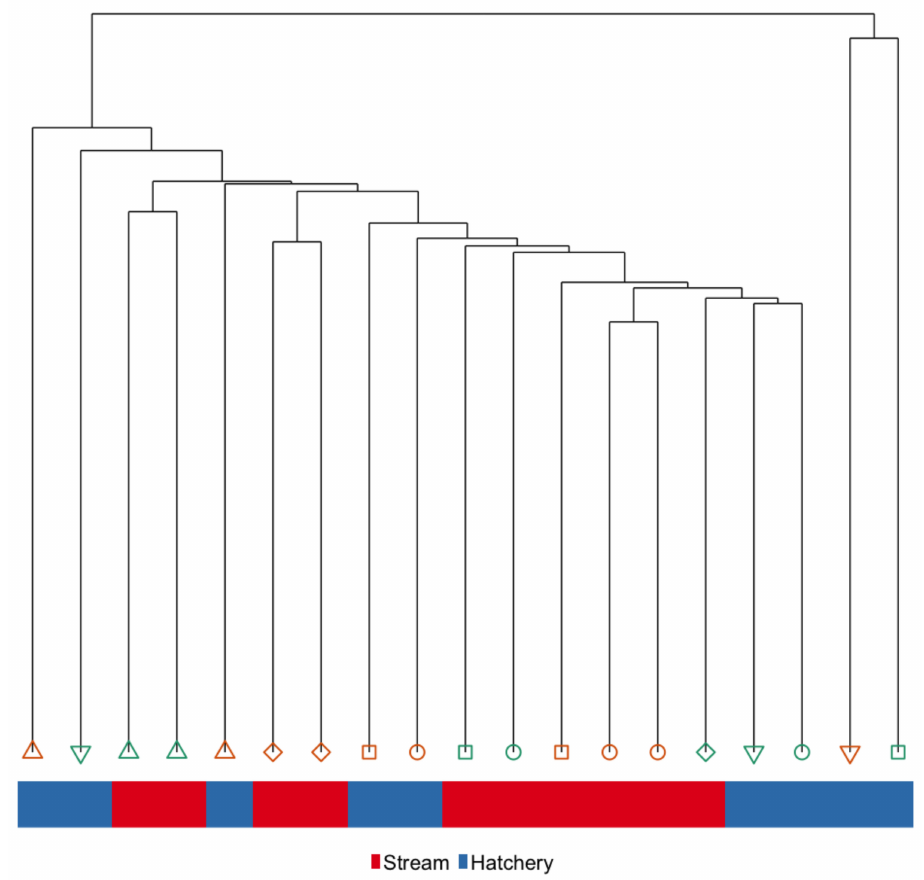
Figure 5. Hierarchical clustering of global DNA methylation patterns in the Persistent sample set. Color of the bar represents rearing-treatment and color / shape represents